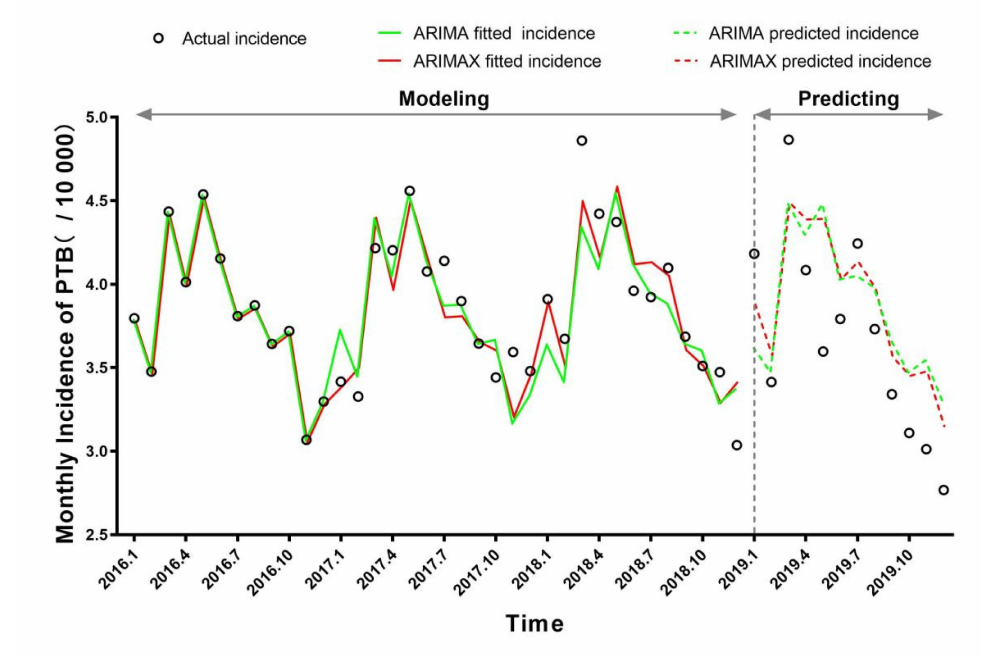
Figure 2. Actual incidence, fitted and predicted incidences of ARIMA (0,0,0) (1,1,0) 12 and ARIMA (0,0,0) (1,1,0) 12 with O 3 (0-month lag) and MAP (11-month lag) in